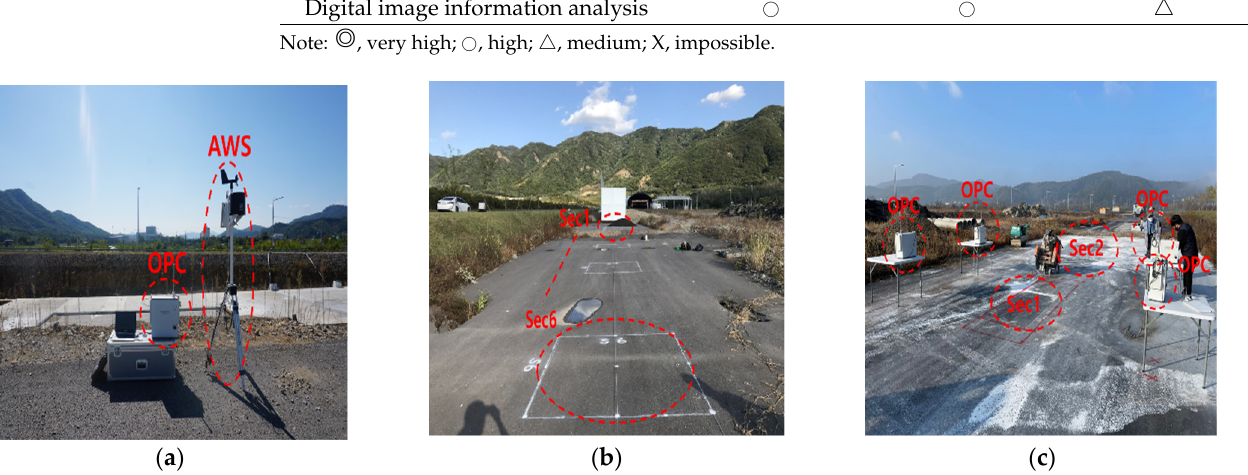
Table 2. Characteristics of PM measurement technology .